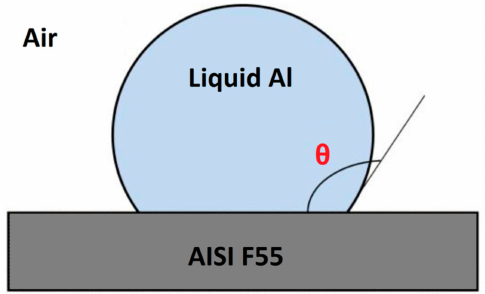
Figure 1. Schematic illustration of contact angles formed by sessile liquid drops on an ideal